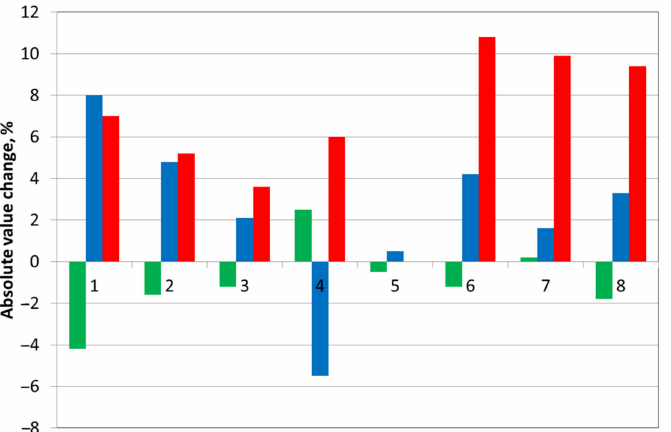
Figure 1. Absolute changes in coke quality indices CSR (green) and CRI (blue), and % change (increase) of the bulk density (red): (1) selective crushing, (2) pre-drying, (3) tar—water emulsion addition, (4) granulation (3% addition of tar—water emulsion), (5) leaning additives (3% pet-coke), (6) vibrating densification (3% addition of tar—water emulsion), (7) pre-drying = briquetting, (8) pre- drying + vibrating densification (3% addition of tar—water emulsion). Source: authors own work based on